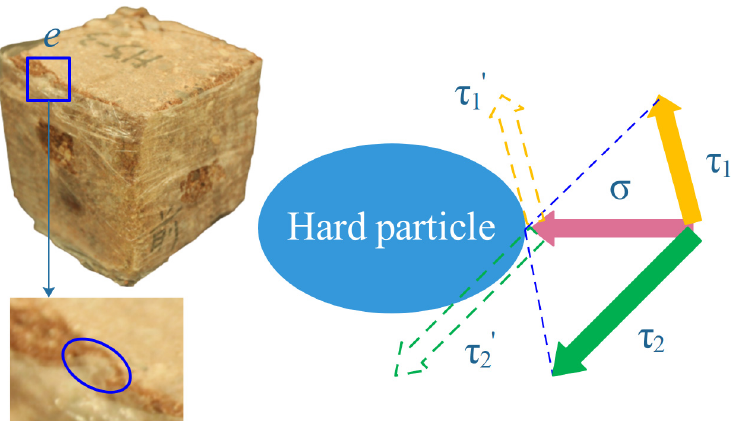
Figure 10. Bifurcation point and stress diagram. Point e is a hard particle, the fracture was subjected to shear stress when passing through the particle, and then a bifurcation occurs.